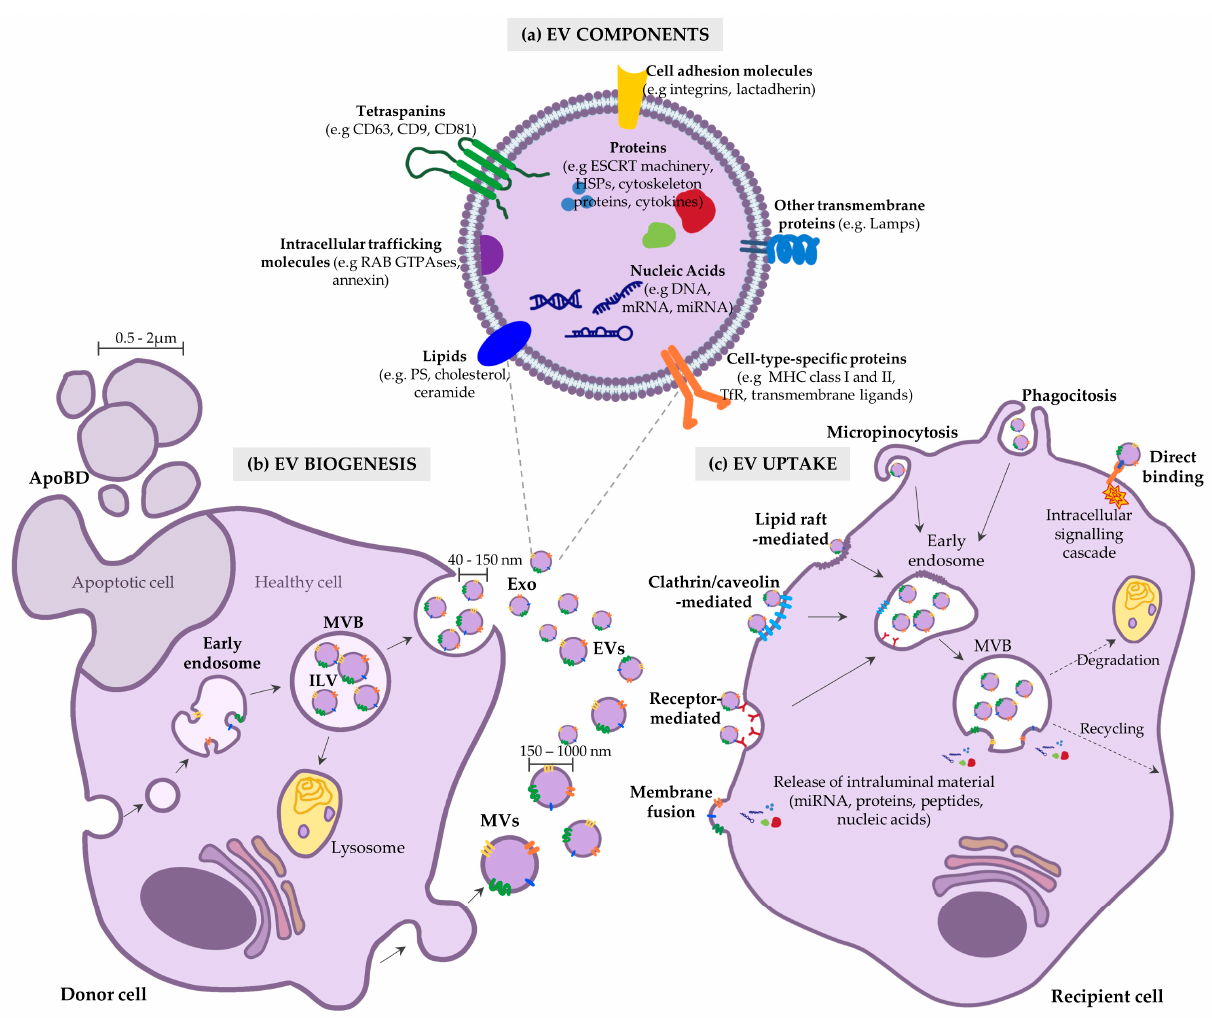
Figure 1. Basics of extracellular vesicle (EV) biology. ( a ) General composition of EVs: EVs are nano- sized lipid bilayer structures that enclose a variety of cellular components including cytosolic and transmembrane proteins, bioactive lipids and nucleic acids. ( b ) Biogenesis of the different subsets of EVs: EVs are formed either by the disassembly of an apoptotic cell into subcellular fragments as apoptotic bodies (ApoBD), the budding of the plasma membrane, in which case they are referred to as microvesicles (MVs) or as intraluminal vesicles (ILVs) within the lumen of multivesicular bodies (MVBs). MVBs fuse with the plasma membrane to release ILVs that are then called exosomes (Exo). ( c ) Mechanisms of uptake of EVs by the recipient cells: EVs can induce a downstream signalling cascade in the recipient cell via direct binding or transfer of their intraluminal content by membrane fusion or endocytosis-mediated internalization. The internalized EVs follow the endosomal pathway and can either be recycled back to the plasma membrane, degraded in the lysosome or undergo endosomal escape releasing their intraluminal cargo. ESCRT—endosomal sorting complex required for transport; HSP—heat shock protein; Lamp—lysosomal-associated membrane proteins;